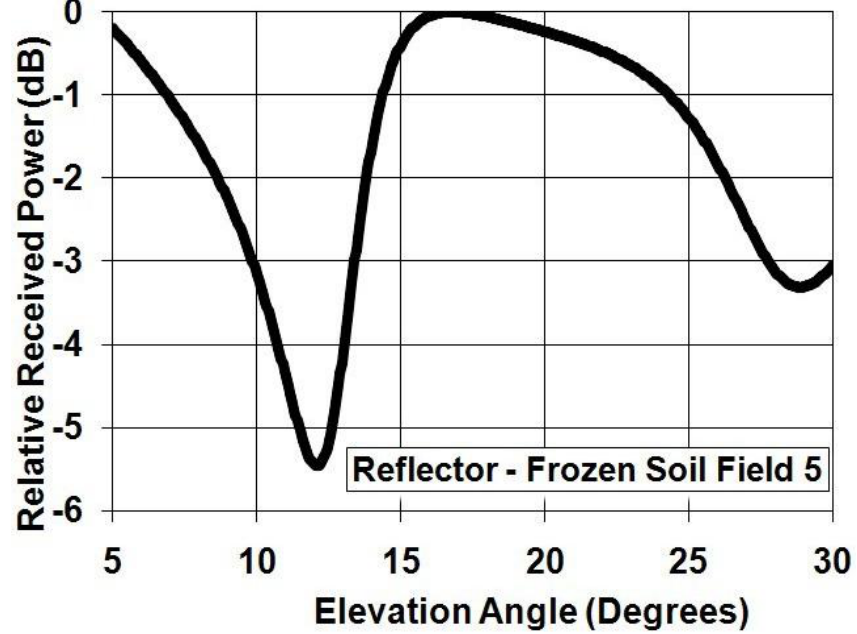
= 1.60 − i 3.58 × 10 −4 and snow